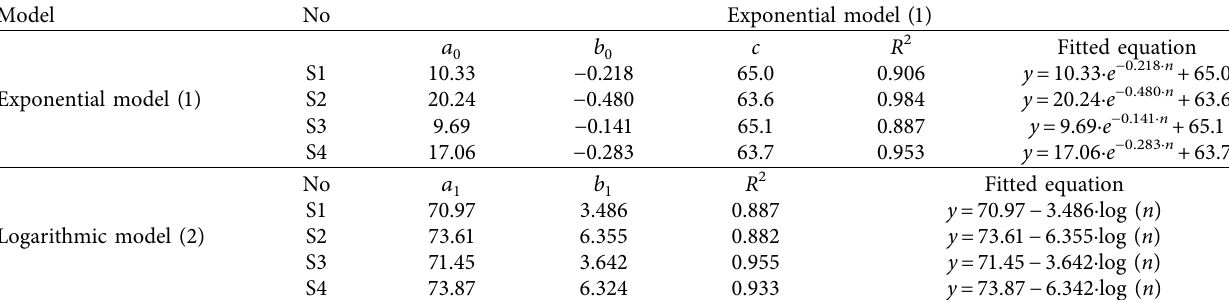
Table 8: BPN attenuation prediction model parameters.